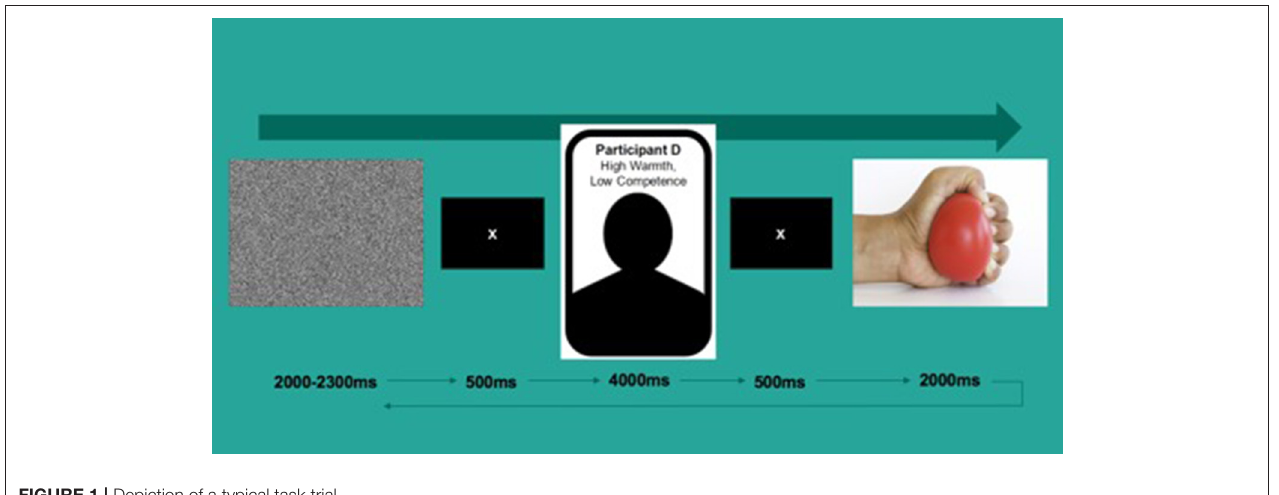
FIGURE 1 | Depiction of a typical task